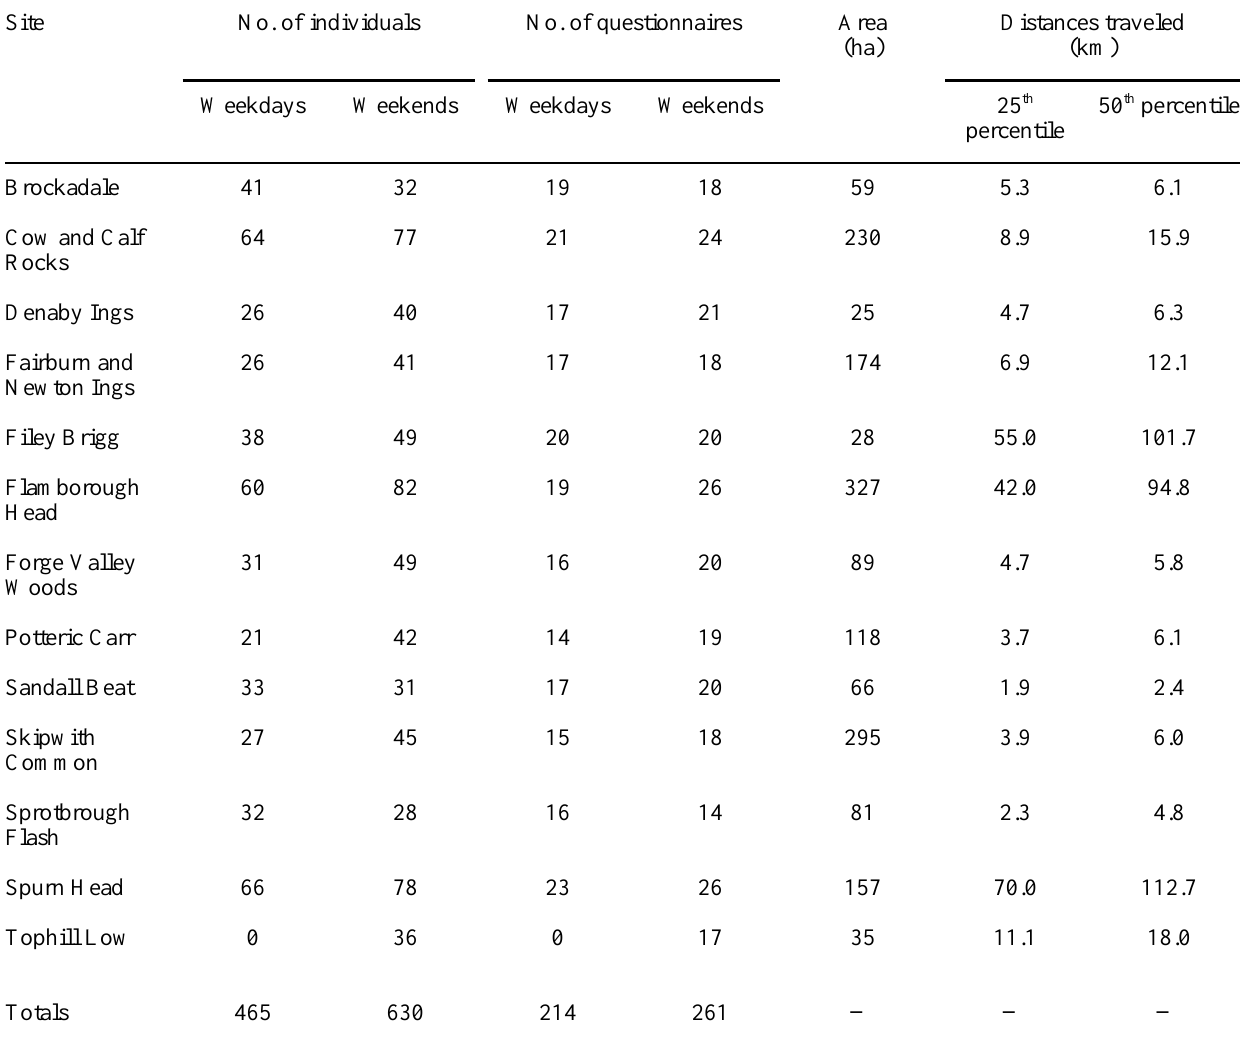
Table 1 . Survey sites, numbers of individuals involved, numbers of questionnaires returned, site areas, and 25th and 50th percentiles of distances